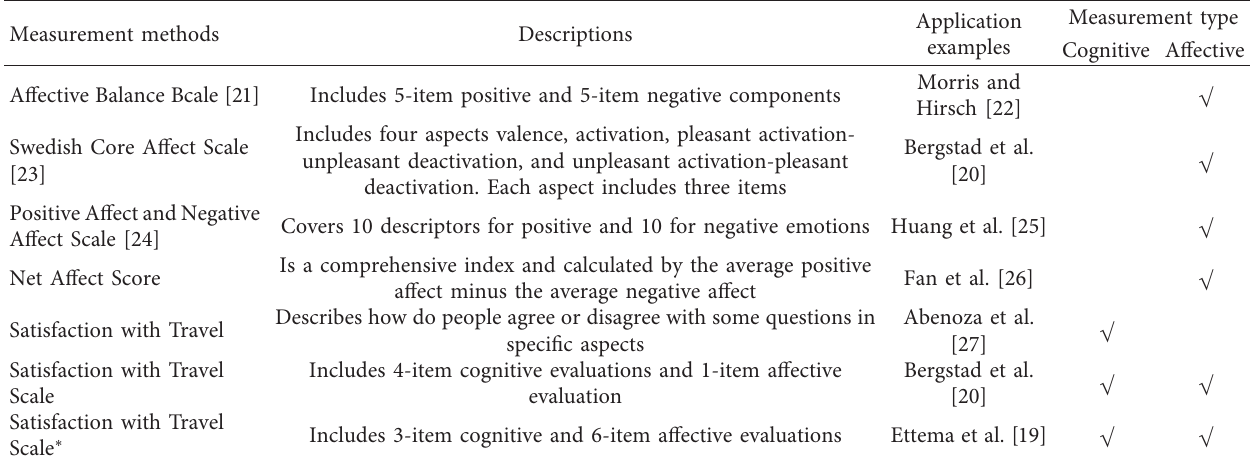
Table 1: Measurement methods of travel